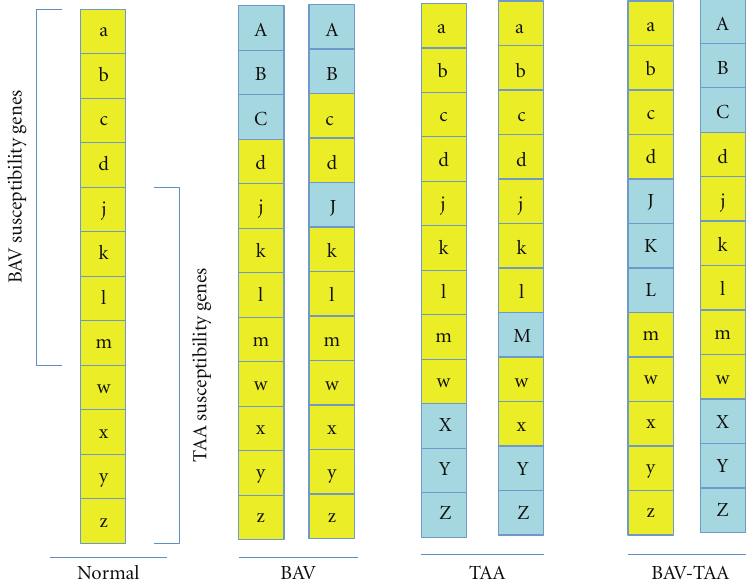
Figure 5: Hypothetical model of shared complex genotype in BAV-TAA. Multiple susceptibility genes exist for both BAV and TAA, and some of these genes are common to both phenotypes (yellow letters, Normal). An una ff ected genotype might have 8 BAV susceptibility genes (a–